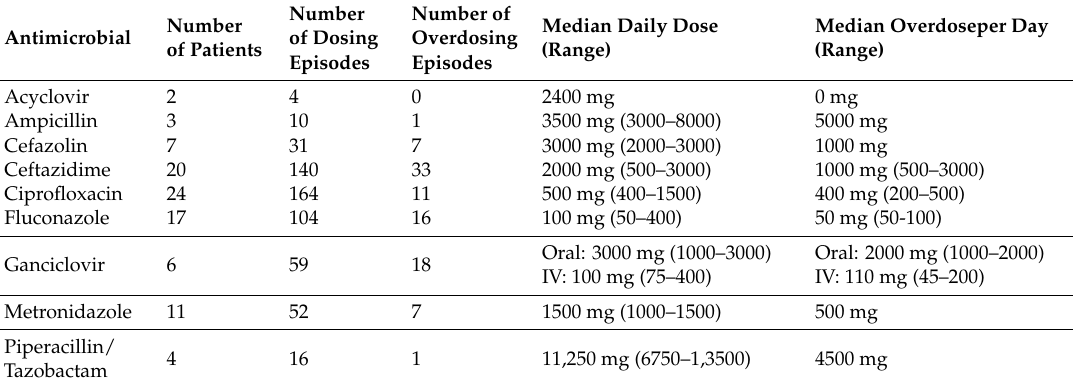
Table 6. Correct doses for Cockcroft Gault but overdosing for modified